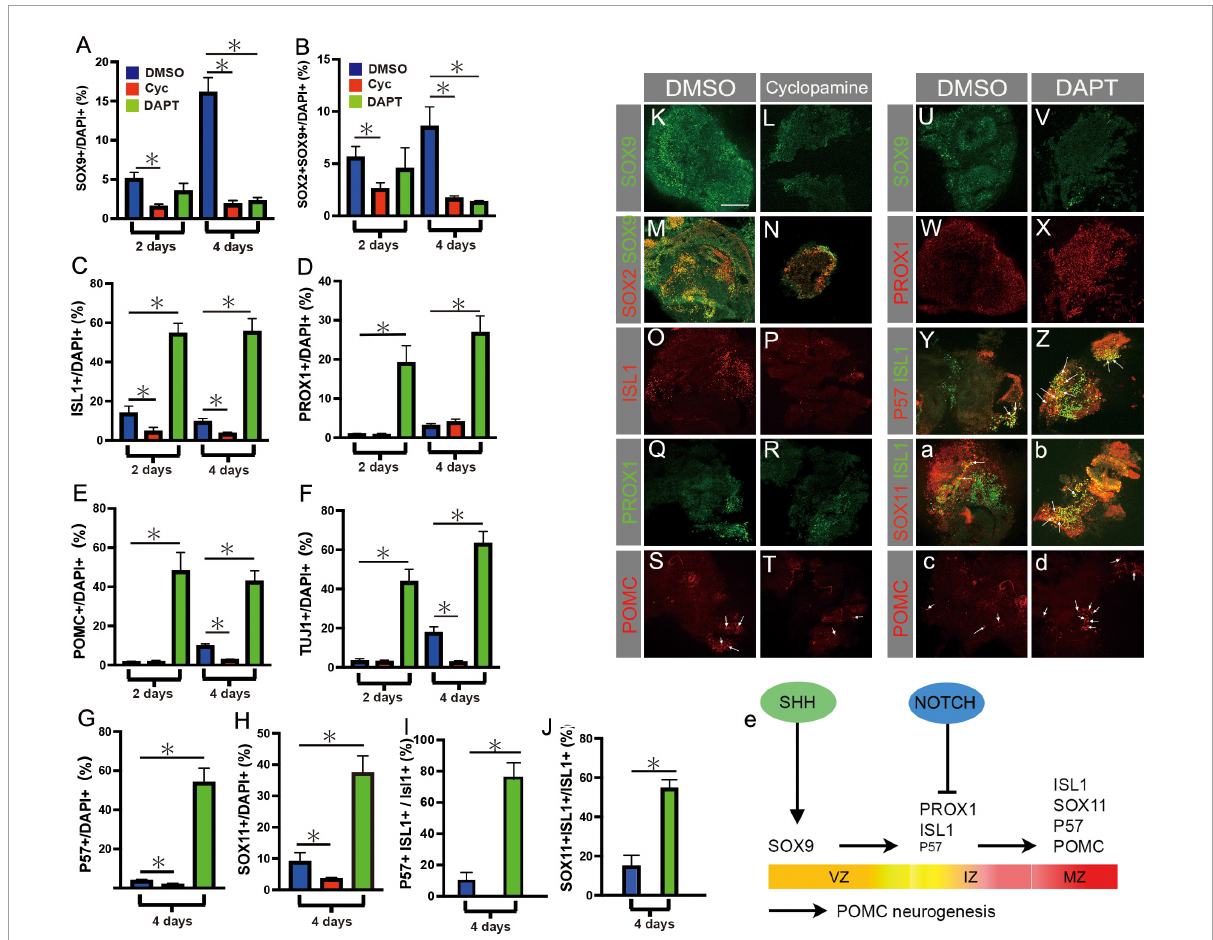
FIGURE5 (A–J) Quantification of results of ex vivo culture experiments conducted on pHyp explants cultured for 2 or 4 days in the presence of DMSO, the SHH inhibitor cyclopamine, or the Notch inhibitor DAPT. Area immunolabelled for SOX9 (A) , SOX2 and SOX9 (B) , ISL1 (C) , PROX1 (D) , POMC (E) , TUJ1 (F) , P57 (G) , SOX11 (H) , normalised to total DAPI+ area. Area immunolabelled for P57 and ISL1, normalised to total ISL1+ area (I) ; area immunolabelled for SOX11 and ISL1, normalised to total ISL1+ area (J) . Mean ± SEM, n = 9–14 (2 days), n = 4–13 (4 days). Asterisks indicate statistical significance at p < 0.05. (K–T) pHyp explants cultured for 2 or 4 days in the presence of DMSO (K,M,O,Q,S) or cyclopamine (L,N,P,R,T) and immunolabelled for SOX9 (K,L) , SOX2 and SOX9 (M,N) , ISL1 (O,P) , PROX1 (Q,R) , and POMC (S,T) . Arrows in (S,T) indicate POMC+ cells. (U–d) pHyp explants cultured for 2 or 4 days in the presence of DMSO (U,W,Y,a,c) or the Notch pathway inhibitor DAPT (V,X,Z,b,d) and immunolabelled for SOX9 (U,V) , PROX1 (W,X) , P57 and ISL1 (Y,Z) , SOX11 and ISL1 (a,b) , and POMC (S,T) . Arrows in (c,d) indicate POMC+ cells.